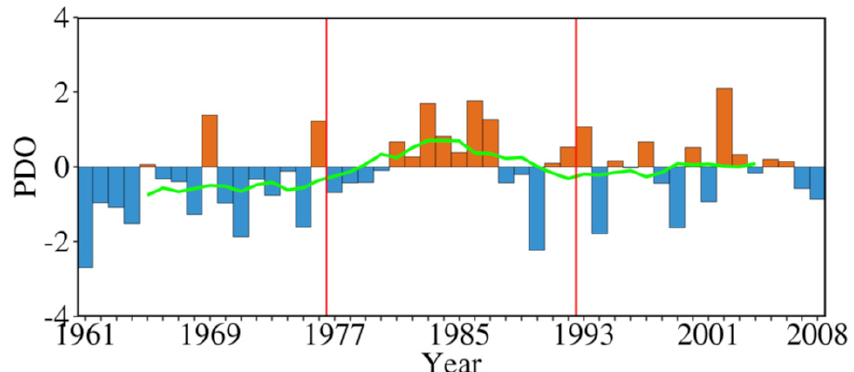
Figure 13. Time series of the December Pacific Decadal Oscillation (PDO) from the period 1961 to 2008. The green line indicates the 9-year running average. The red vertical lines indicate the change points around 1976/1976 and 1992/1993 based on the December rainfall time series for reference discussion.